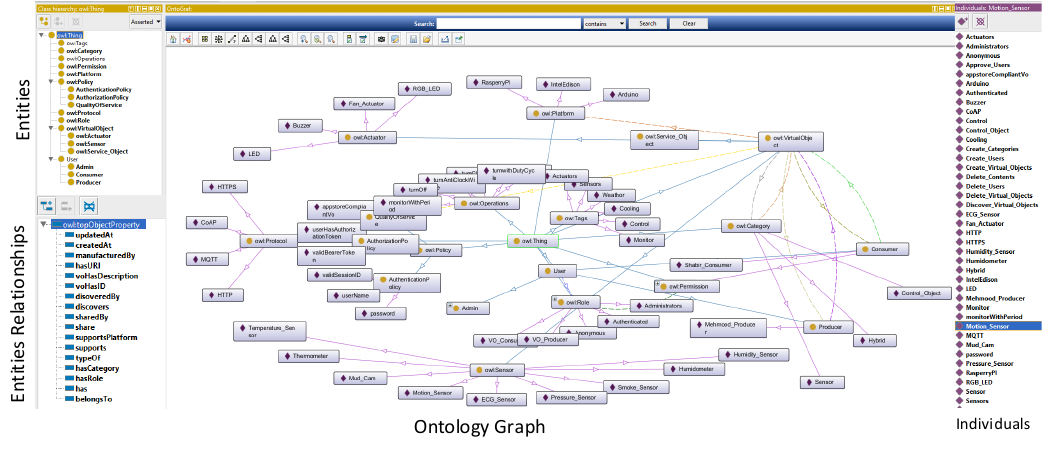
Figure 6. Semantic knowledge representation graph based on Protege